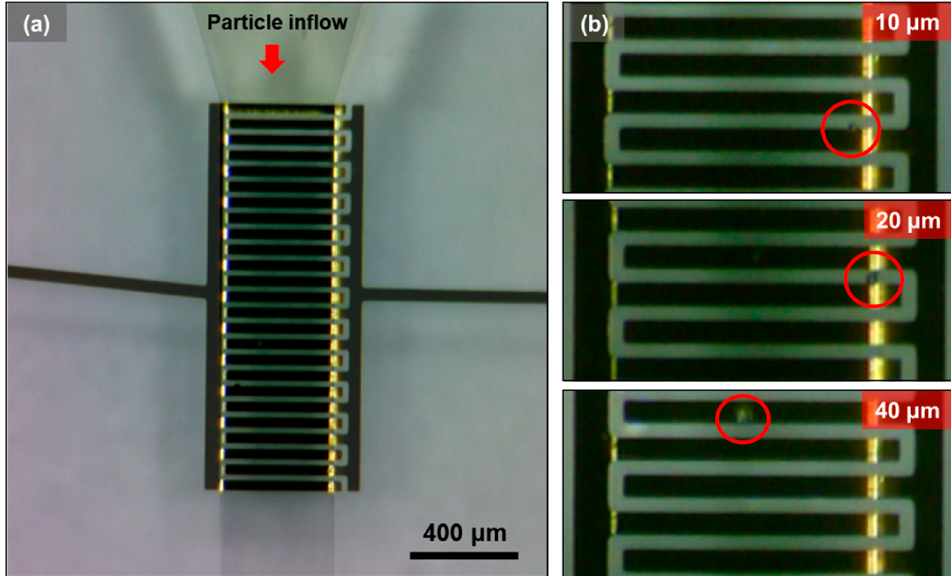
Figure 9. ( a ) Optical paragraph of the detection region marked with flow direction and ( b ) video frames of particles passing through by size (d = 10, 20, and 40 μ m).